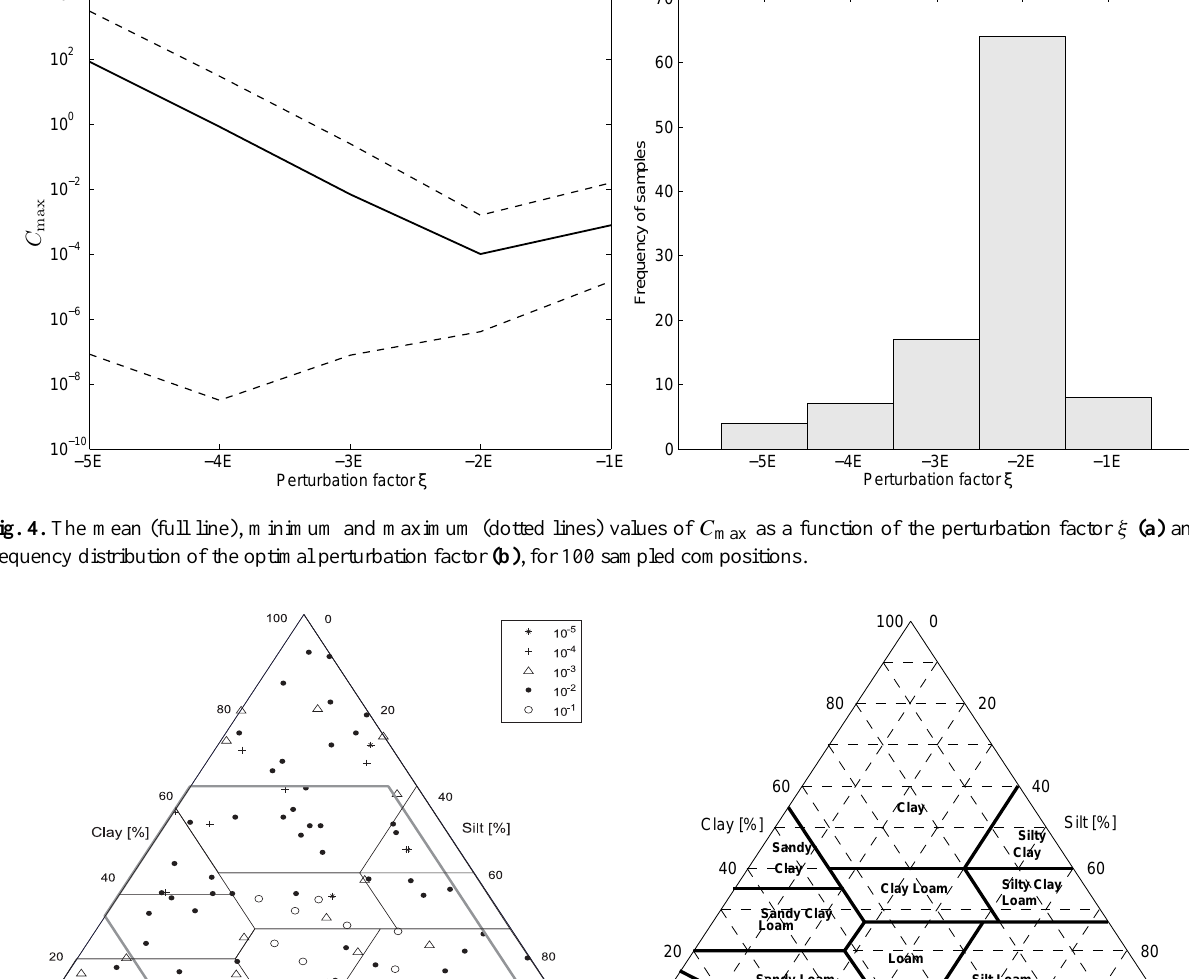
Fig. 5. Distribution of the optimal perturbation factor ξ (100 samples) in the texture triangle (a) with identifica- tion of the USDA soil classes (b).